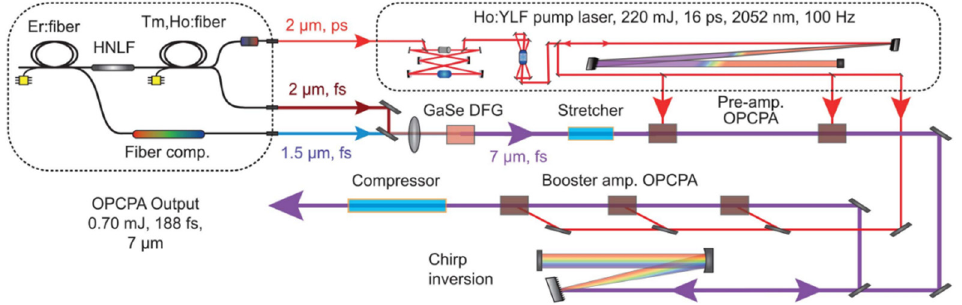
Figure 13. Layout of the 7 μ m OPCPA. The MIR seed was generated using the two broadband femtosecond outputs from a three-color fiber frontend via DFG. Afterwards, the MIR pulses were stretched in a dielectric bulk and consecutively amplified in a pre-amplifier and a booster amplifier separated with a chirp inversion stage. Maximum efficiency of the OPCPA was achieved by tailoring the seed-to-pump pulse durations in the pre-amplifier and booster amplifier. The broadband high-energy MIR pulses were recompressed using a dielectric bulk rod of BaF 2 . Reprinted with permission from [55].